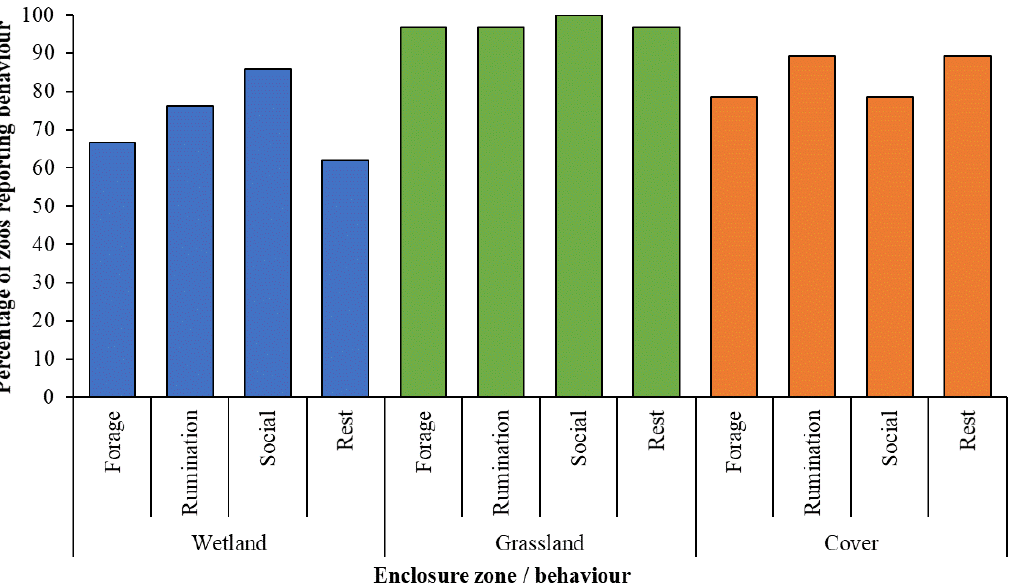
Figure 3. Self-reported observation of key state behaviours performed per enclosure zone from all surveys that noted lechwe behaviour. Percentages are calculated from records of behaviour from those zoos that stated their lechwe were provided with that enclosure zone.